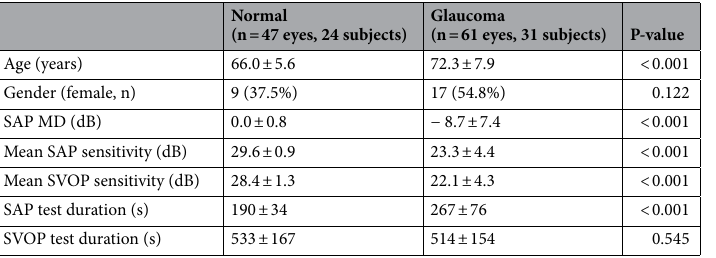
Table 1. Demographic and clinical details of all participants included in the study. SAP standard automated perimetry, MD mean deviation, dB decibels, SVOP saccadic vector optokinetic perimetry, s seconds.